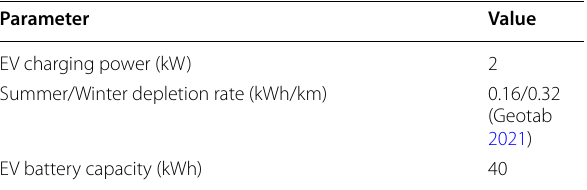
Table 2 Assumed parameters for Regina case